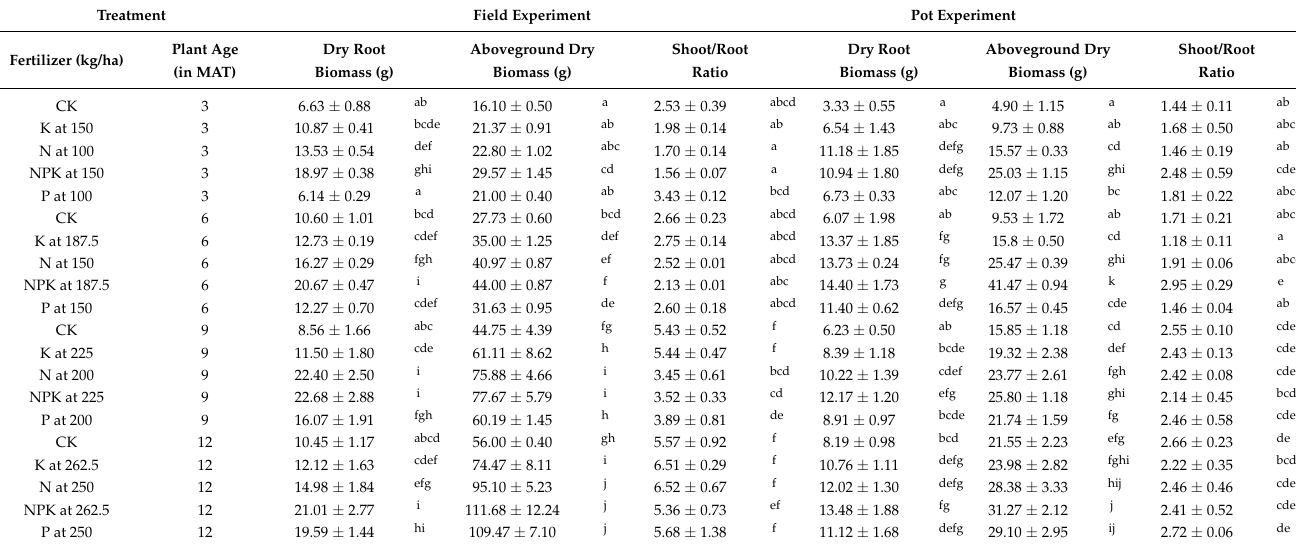
Table 2. Effects of inorganic fertilizers on biomass yield of C. sanguinolenta at different plant growth